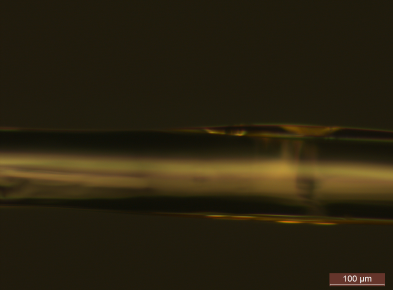
Figure 1. Microscope image of the PI-coated FBG that is deposited by hand on bare FBG in the